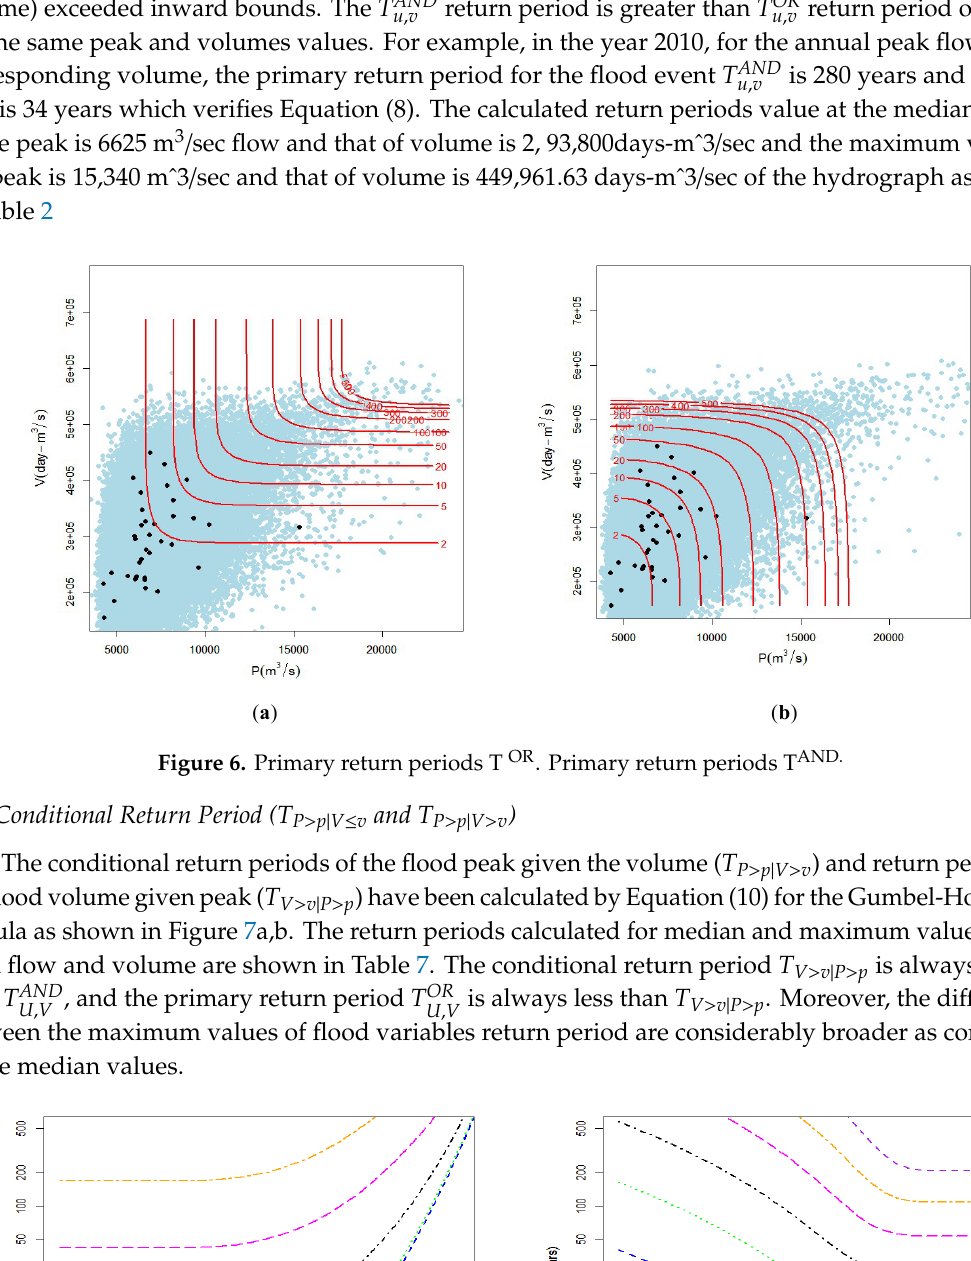
Figure 6. Primary return periods T OR . Primary return periods T AND.